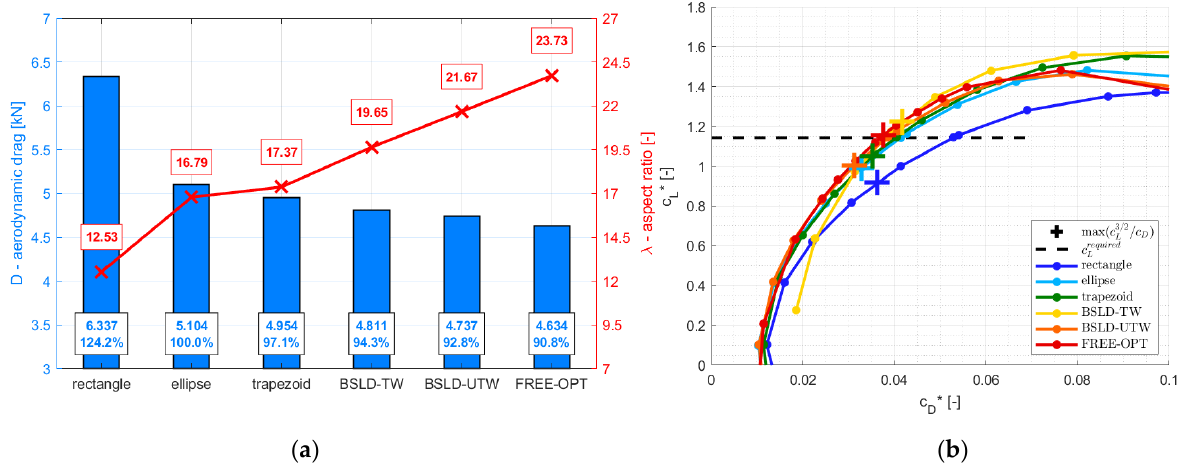
Figure 8. Image ( a ) shows comparison of the aerodynamic drag on individual wing with their aspect ratio, ( b ) shows their polars dashed line labels required lift coefficient, crosses label optimal values of the 𝑐 (cid:3013)(cid:2871) (cid:2870)⁄ 𝑐 (cid:3005) (cid:3415) , which corresponds to minimum required power.